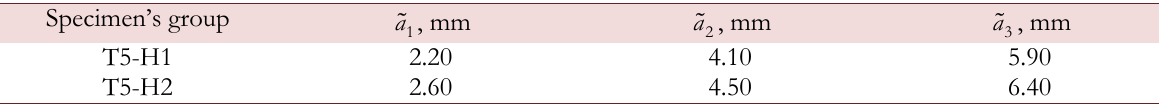
Table 5: Averaged notch length.